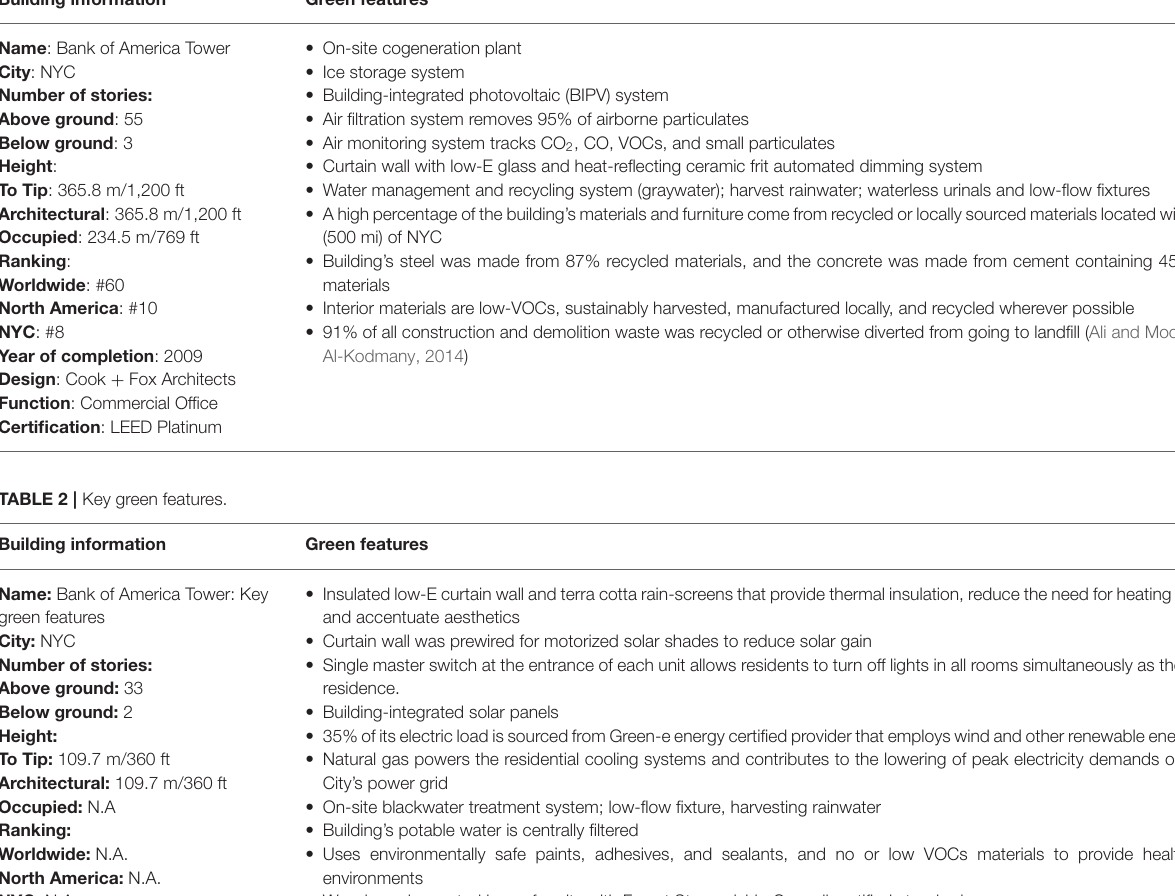
TABLE 1 | Bank of America Tower: Key green features. Building information